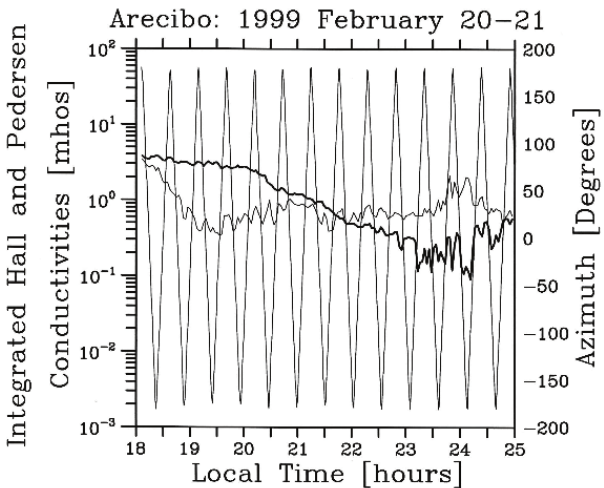
Fig. 7. Integrated Hall (light line) and Pederson (heavy line) con-